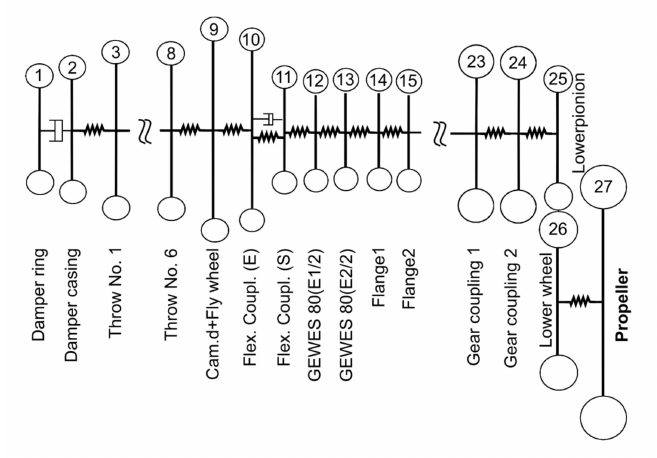
Figure 6. Mass elastic model used in theoretical calculation of torsional vibration.